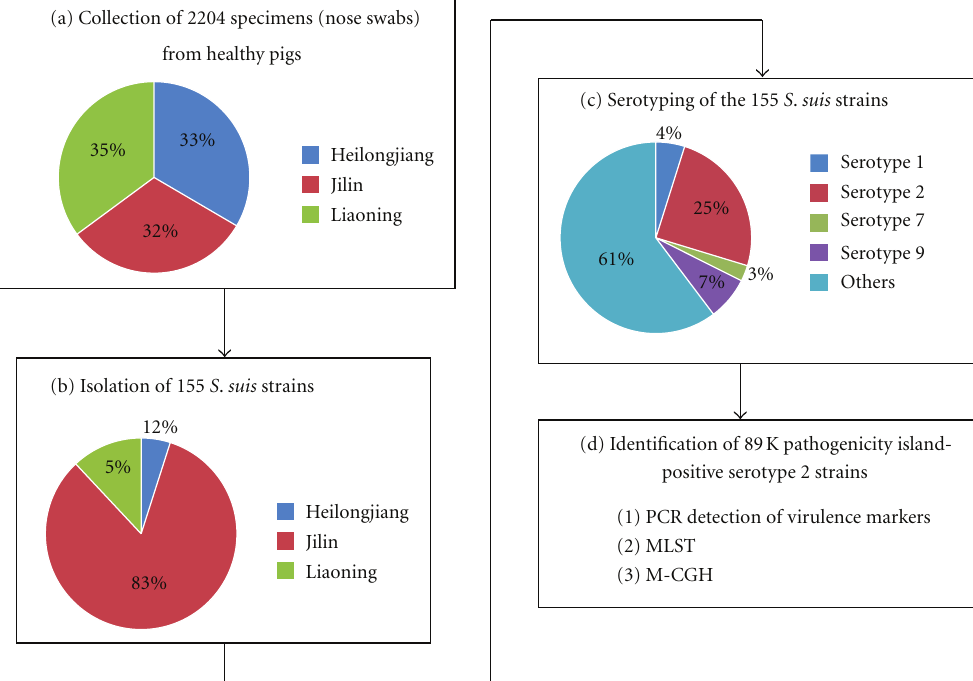
Figure 1: Flow charts of the analyses in this